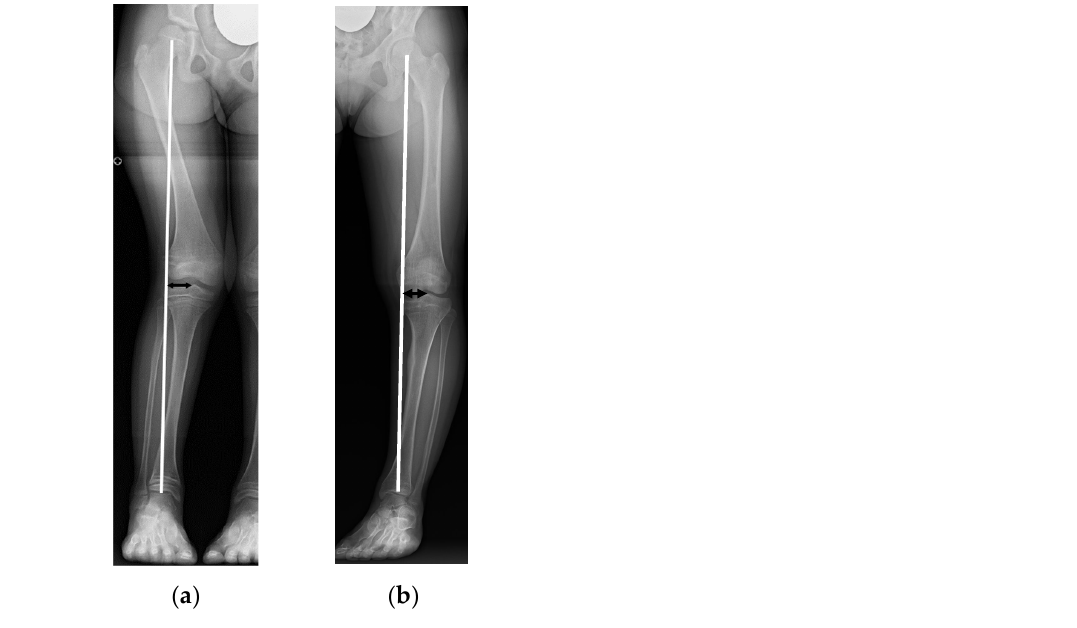
Figure 1. Mechanical axis deviation (MAD) and varus or valgus deformity of a lower limb. The mechanical axis is defined as the line between the center of the femoral head and the center of the ankle joint (white line). Mechanical axis deviation is defined as the displacement of the mechanical axis from the center of the knee joint. ( a ) Valgus deformity of the lower limb exists because of the lateral displacement of the MAD. ( b ) Varus deformity of the lower limb exists because of the medial displacement of the MAD.